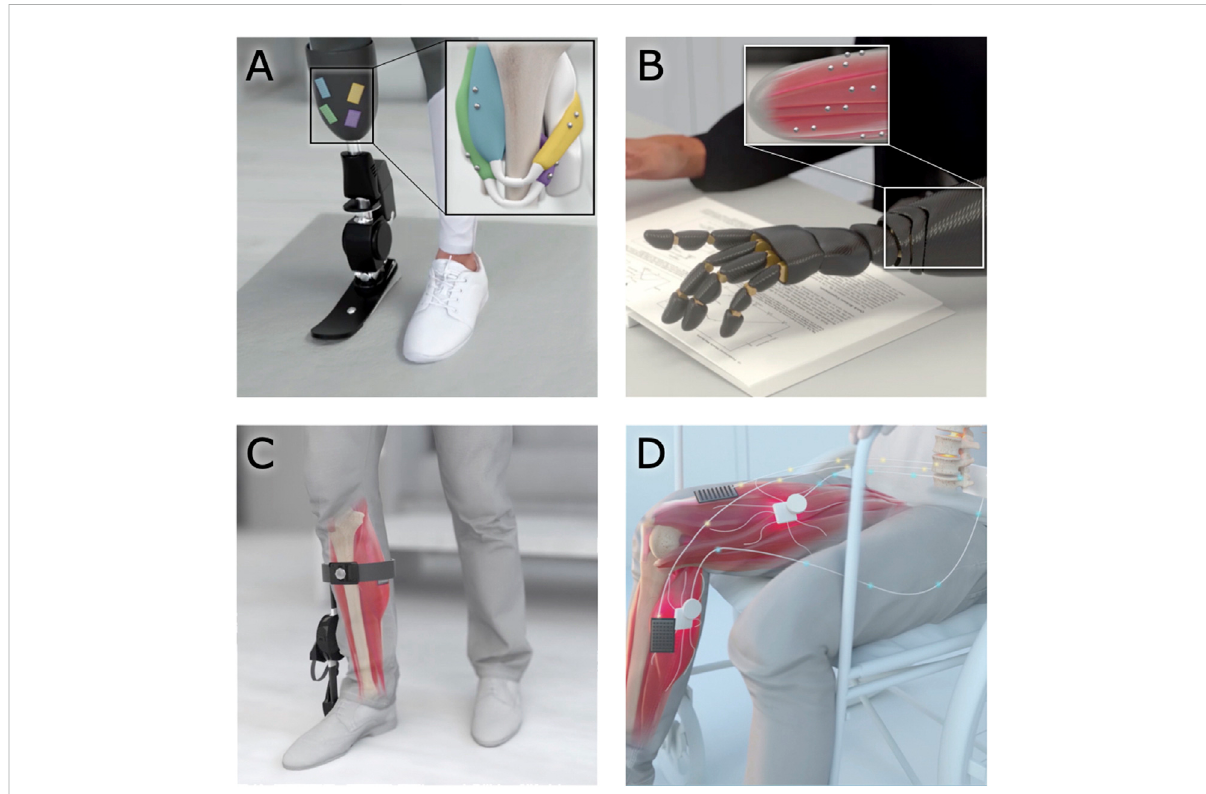
FIGURE 8 Applications of magnetomicrometry. When used to track muscle tissuelengths via magnetomicrometry, magnetic bead implants could enable real-time control in human-machine interfaces. (A,B) Magnetic beads implanted into residual muscles could be used to control a prosthetic limb device. (C) Whenimplantedinaweakenedmuscle,themagneticbeadscouldprovidecontroloveranexoskeletonforrestorationoraugmentationof joint torque. (D) Magnetic beads in paralyzed muscles could enable closed-loop arti fi cial muscle stimulation for control of muscle length or